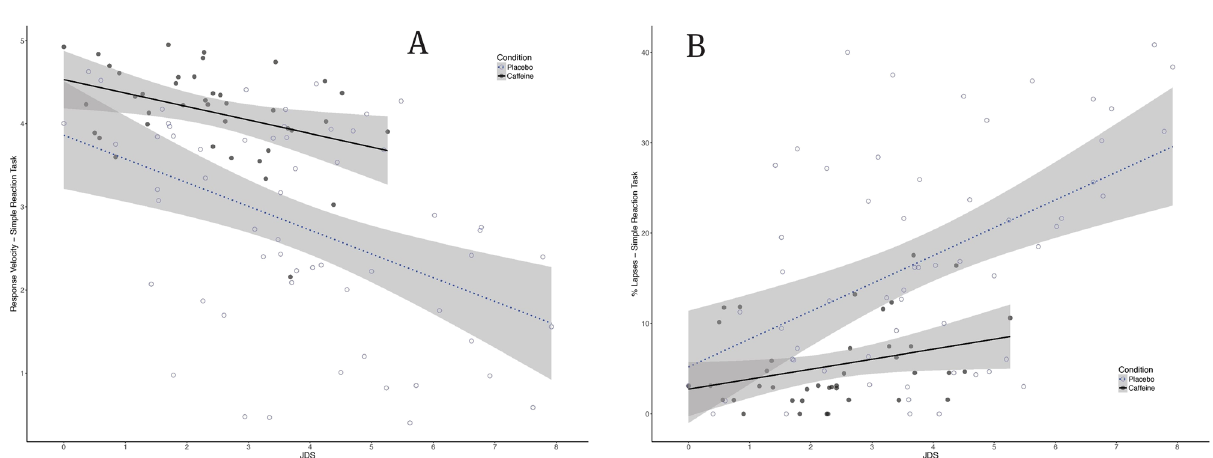
Figure 4. Performance on the Simple Reaction task (3-min PVT) as a function of drowsiness (JDS scores averaged over 5 min prior to the PVT task) for the caffeine (black filled circle, n = 4) and placebo (black open circle, n = 6) groups across our 50-h TSD protocol. ( A ) Response velocities (fastest 10% reactions, s −1 ). ( B ) Percentage of Response Lapses (reaction time > 355 ms). Shaded areas represent 95% CIs over regression